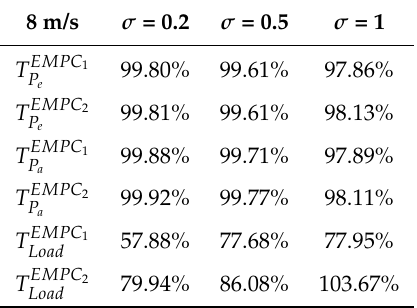
Table 9. The rate of EMPCs to MPC with wind speed noise at an average wind speed of 11 m/s. 11 m/s σ = 0.2 σ = 0.5 σ = 1 T EMPC 1 P e